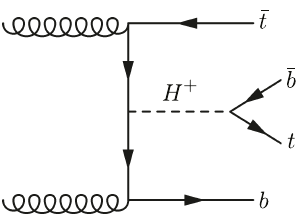
Figure 1 . Leading-order Feynman diagram for the production of a heavy charged Higgs boson in association with a top antiquark and a bottom quark, as well as its decay into a top quark and a bottom